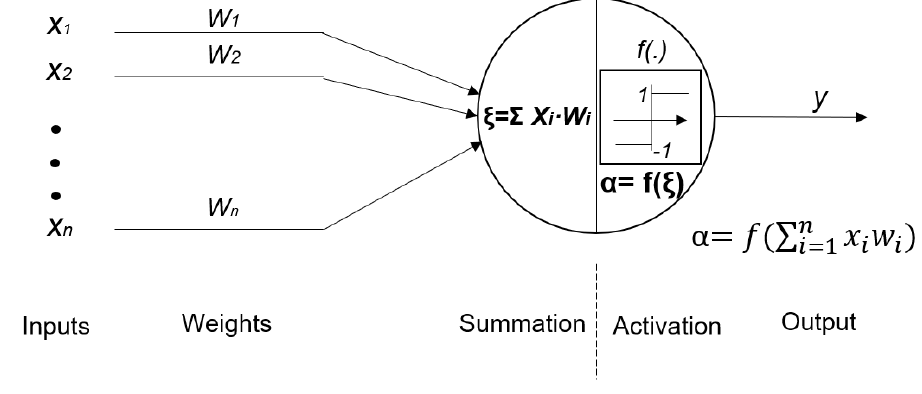
Figure 3. The basic scheme of a neuron.